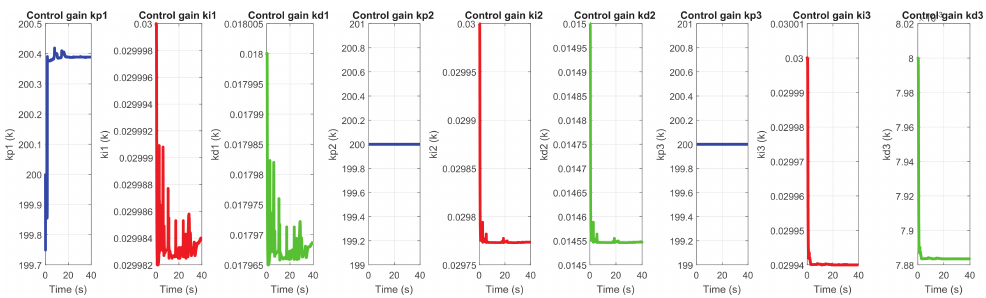
Figure 36. Self-tuning of gains k p , k d and k i in exercise